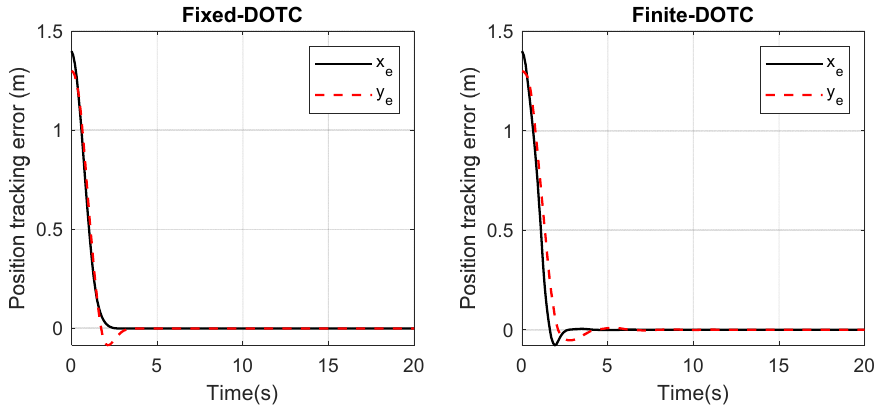
Figure 14. The position tracking errors in part 3.